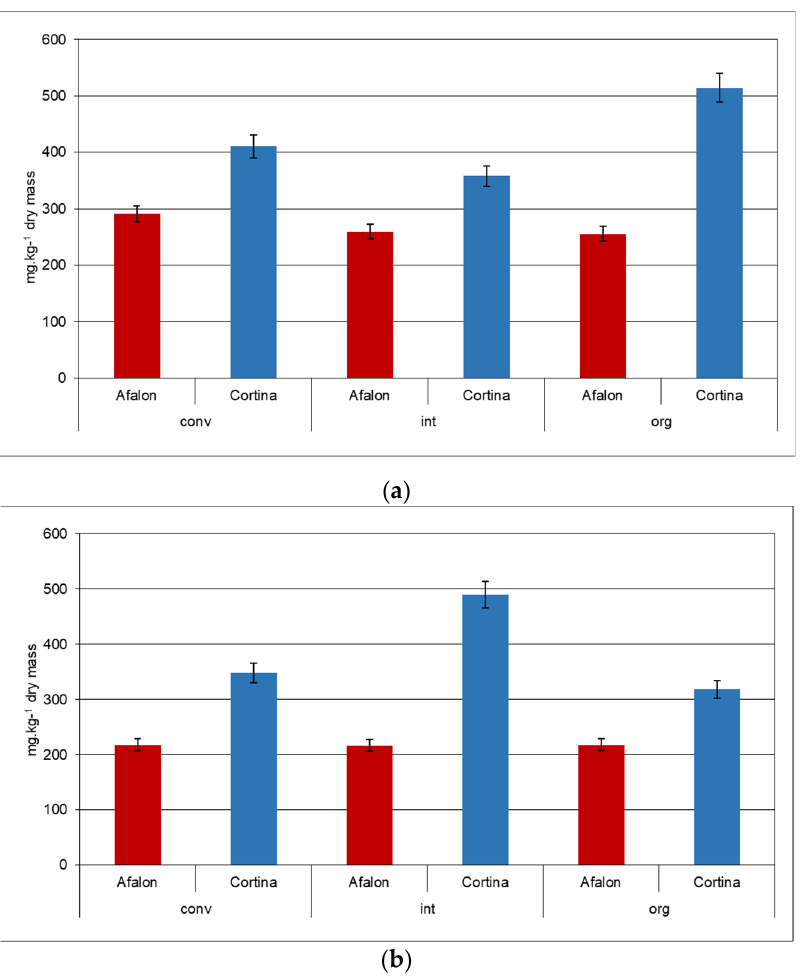
Figure 1. Content of AA in Cortina and Afalon cv. produced in conventional (conv), integrated (int), and organic (org) systems: ( a ) seeding density 6 × 10 5 seeds.ha − 1 ; ( b ) seeding density 9 × 10 5 seeds.ha − 1 . The amount of AA is expressed in mg per kg DW.